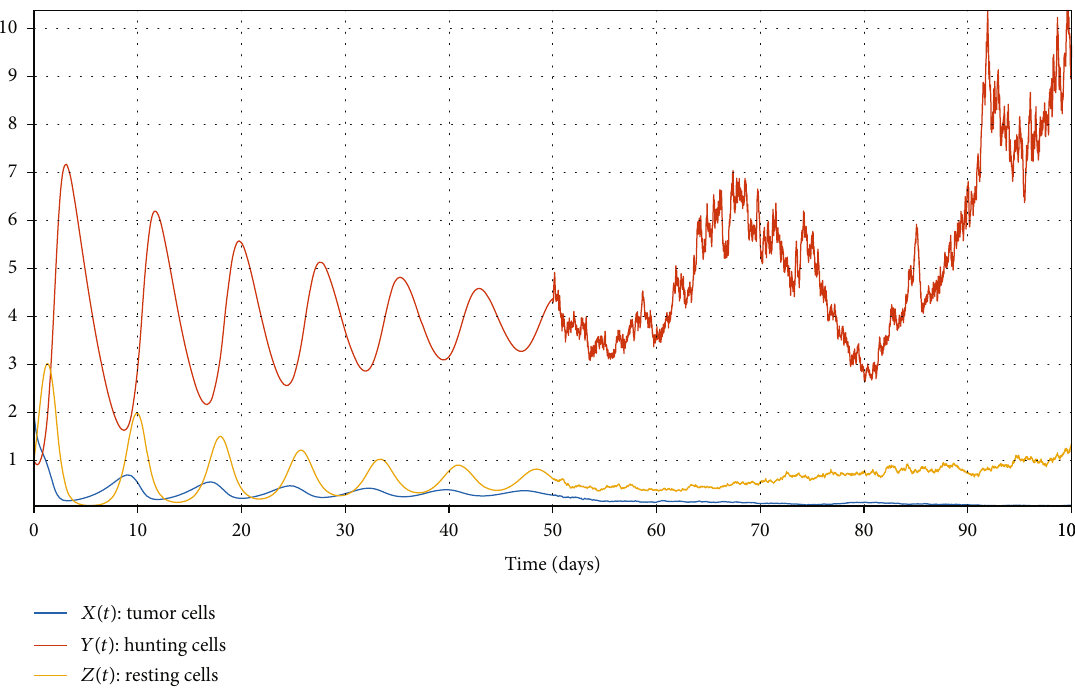
= 0 : 9 , c = 0 : 65 , c = 0 : 21 , c = 0 : 55 , c = 0 : 52 , c = 0 : 39 , c 1 2 3 4 5 6 7